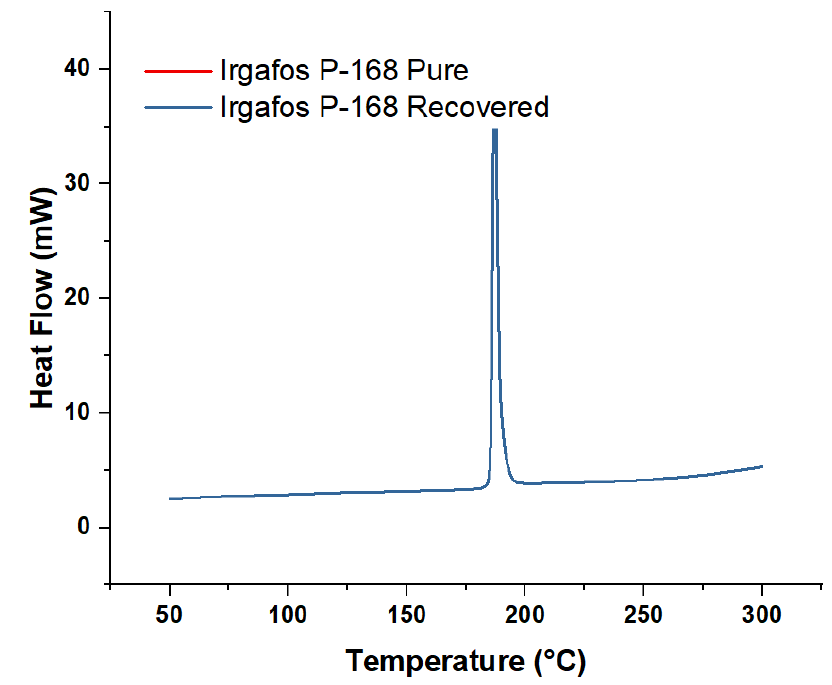
Figure 13. DSC Irgafos 168 pure and DSC Irgafos 168 recovered.